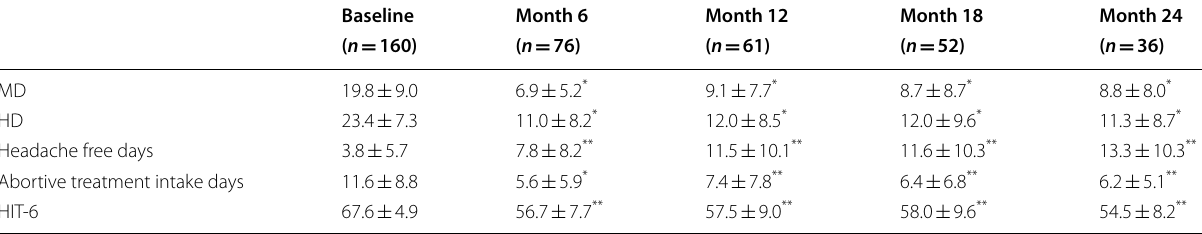
All values are expressed in mean monthly numbers HD Headache days, MD Migraine days, MMD Monthly migraine days * P < 0.001, ** P <